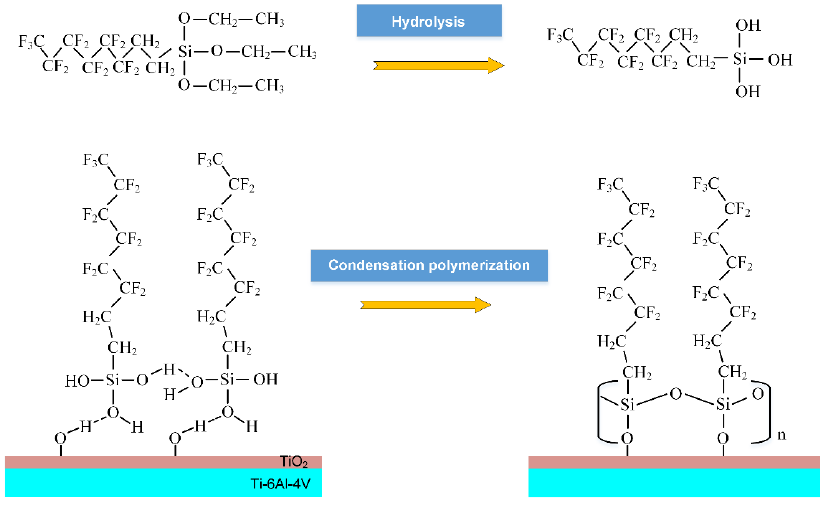
Figure 5. Schematic diagram of the chemical grafting process of fluorination.